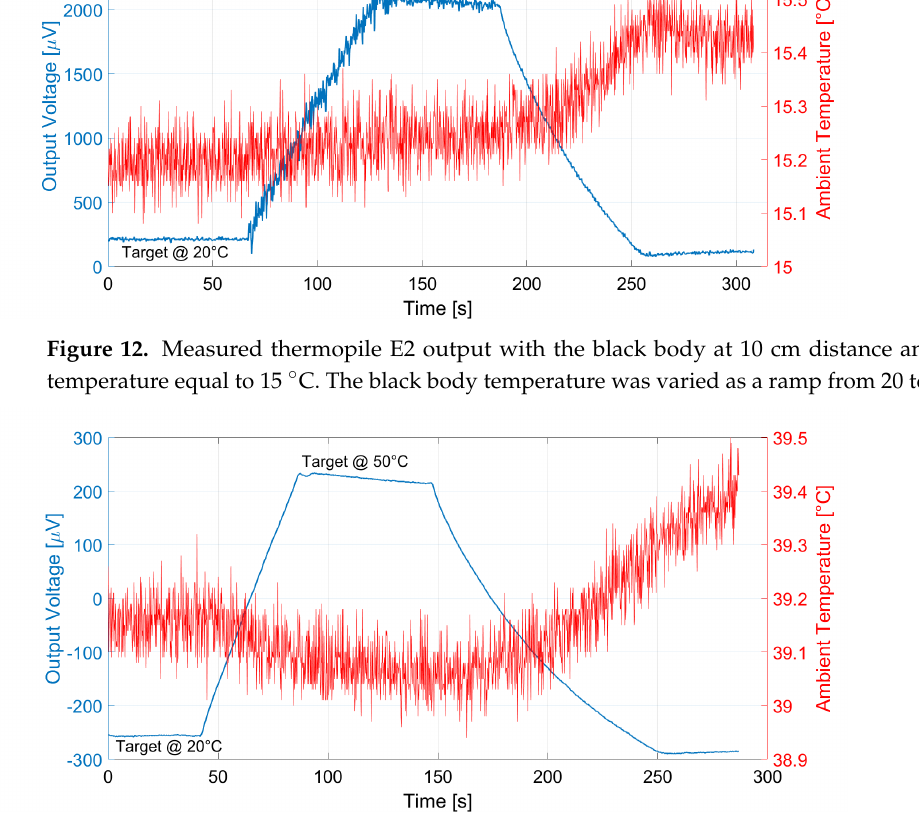
Figure 13. Measured thermopile E1 output with the black body at 10 cm distance and ambient temperature equal to 40 ◦ C. The black body temperature was varied as a ramp from 20 to 50 ◦ C.